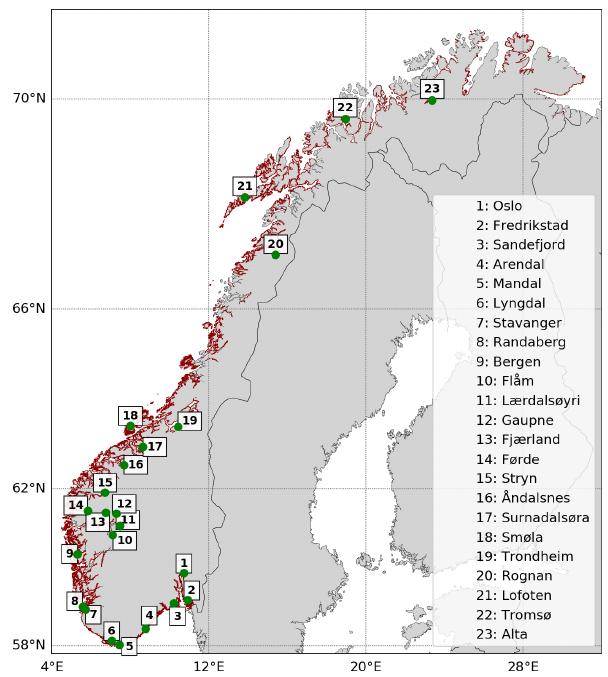
Figure 3. Red lines indicate areas covered by the inundation maps in December 2018. Information for all water levels is not available for all mapped zones due to a lack of knowledge of ocean tides for parts of the coast. In these zones, only the storm surge return heights can be calculated because they are not referenced to MHW. The green markers indicate locations discussed in the text.